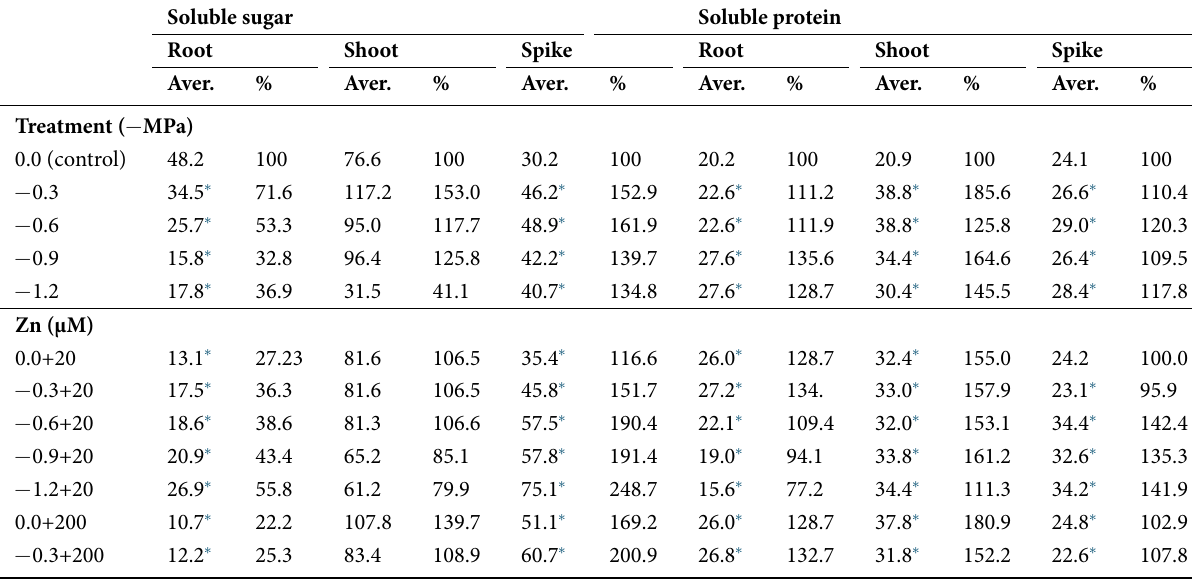
Table 2 Contents of soluble sugars (mg/g dry matter) and soluble protein (mg/g dry matter) in roots, shoots and spikes of wheat treated by different osmotic stress levels with or without Zn (20 and 200 μM) or Ni (1 and 100 μM)